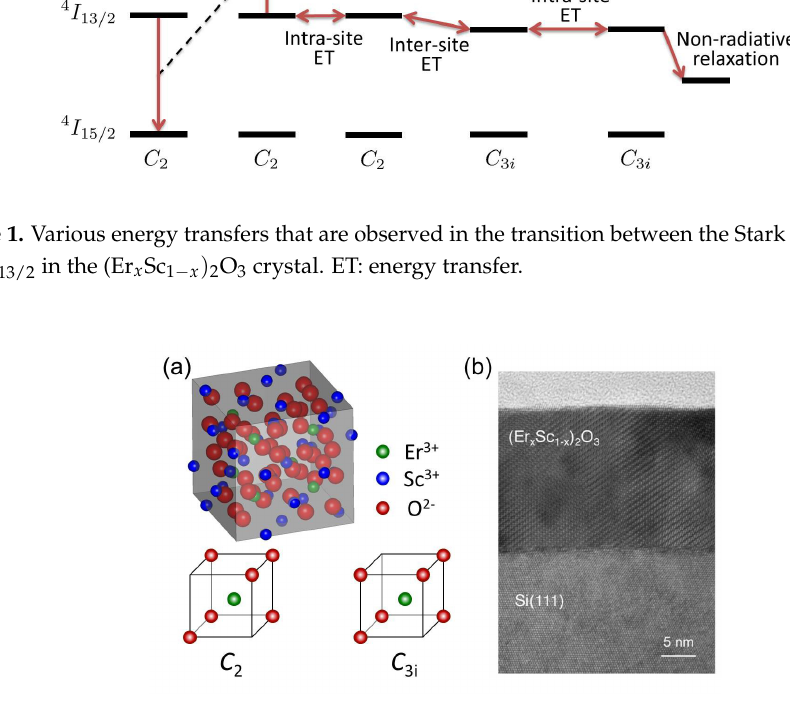
Figure 2. ( a ) Unit cell of bixbyite (Er x Sc 1 − x ) 2 O 3 crystal. In this schematic, Er 3 + at the C 2 site are replaced by Sc 3 + . (lower panel) the configurations of C 2 and C si sites. ( b ) Cross-sectional transmission electron microscope (TEM) image of grown (Er x Sc 1 − x ) 2 O 3